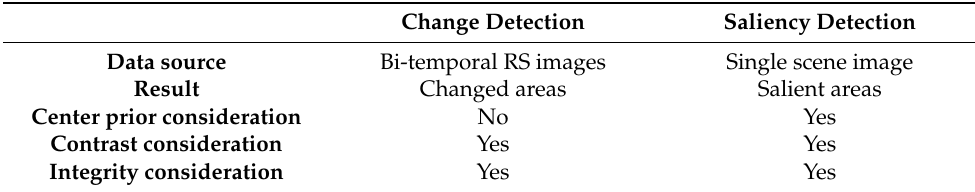
Table 2. Differences and similarities between change detection and saliency